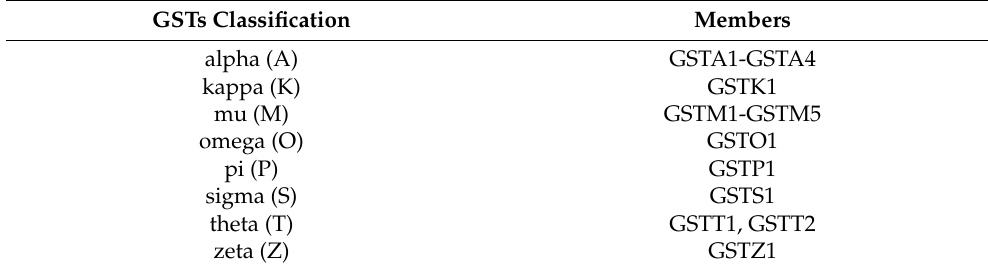
Table 2. The classification of GSTs in human.